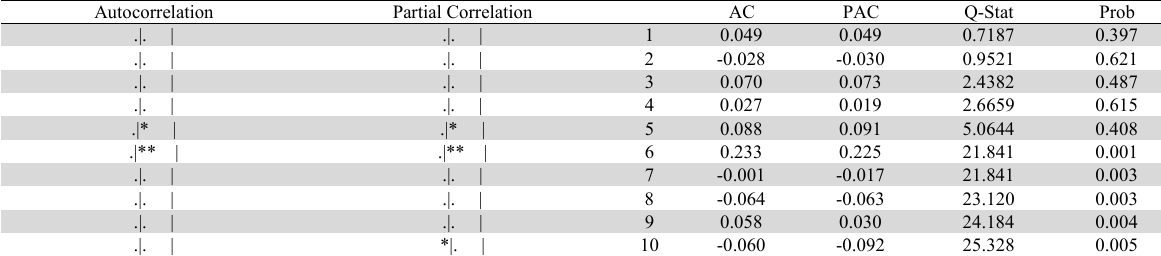
Exhibit the Pre-Estimation Model Output of Residual Diagnostics Correlogram Squared Residuals Statistics Autocorrelation Partial